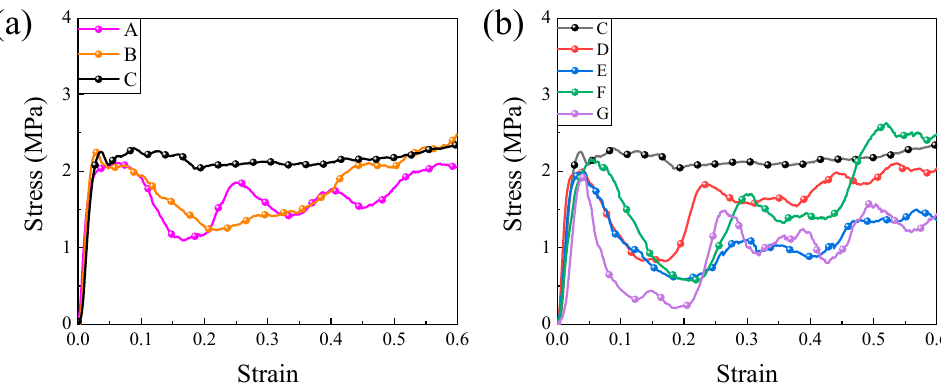
Figure 5. ( a ) Compression curve of lattices of the same length and different diameters; ( b ) Compression curve of lattices of the same diameters and different lengths.